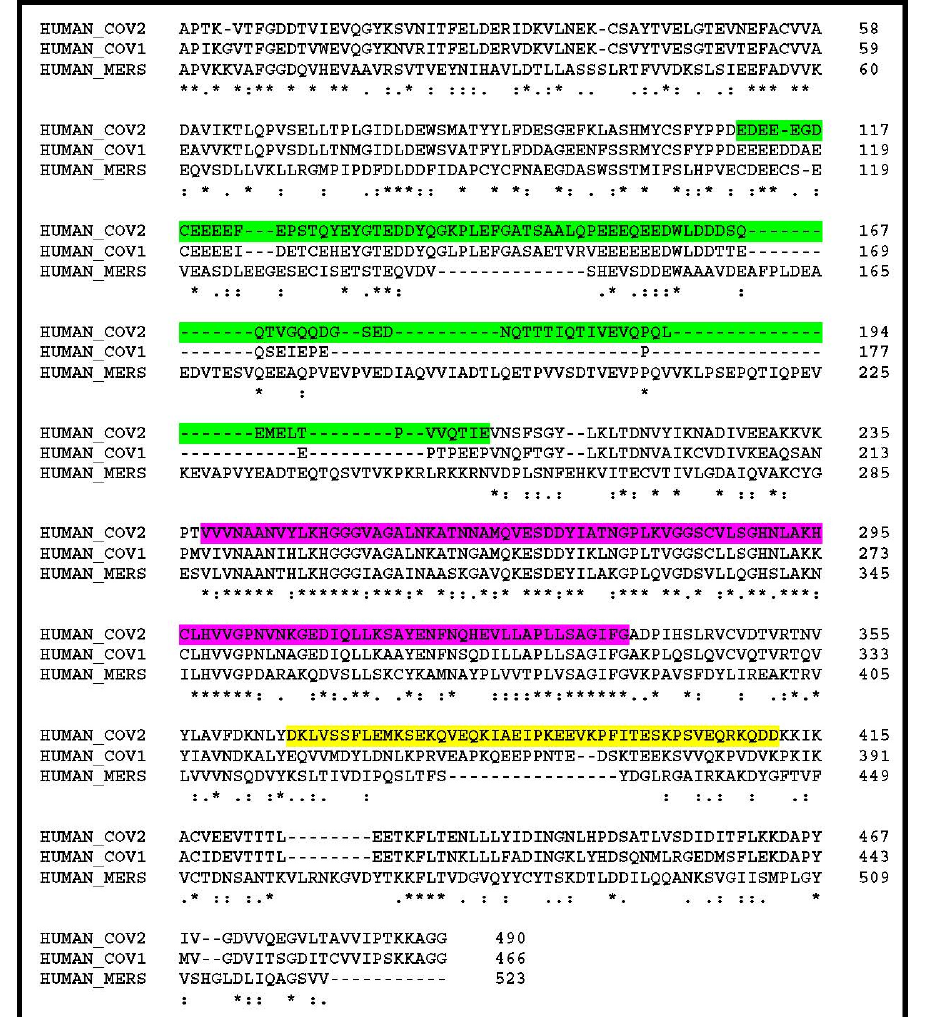
Figure 2. Comparison of the N-term regions of the SARS-CoV-2, SARS-CoV-1, and MERS-CoV nsp3 polyproteins. The glutamine-rich hypervariable region (HVR) is highlighted in green. The conserved ADP-ribose binding site is highlighted in purple. A region of lower similarity between SARS-CoV-2 and SARS-CoV-1 is also seen between positions 365 and 411 (highlighted in yellow). The rest of the SARS-CoV-2 and SARS-CoV nsp3 polyproteins are more than 80% identical, but less than 31% identical with that of MERS-CoV. Strictly conserved positions are indicated by “*”, conservative variations by “:” or “.”, insertions by “-”. Genbank accession numbers: CoV2: YP_009725299, CoV1: AAP13439, MERS: AGV08404.